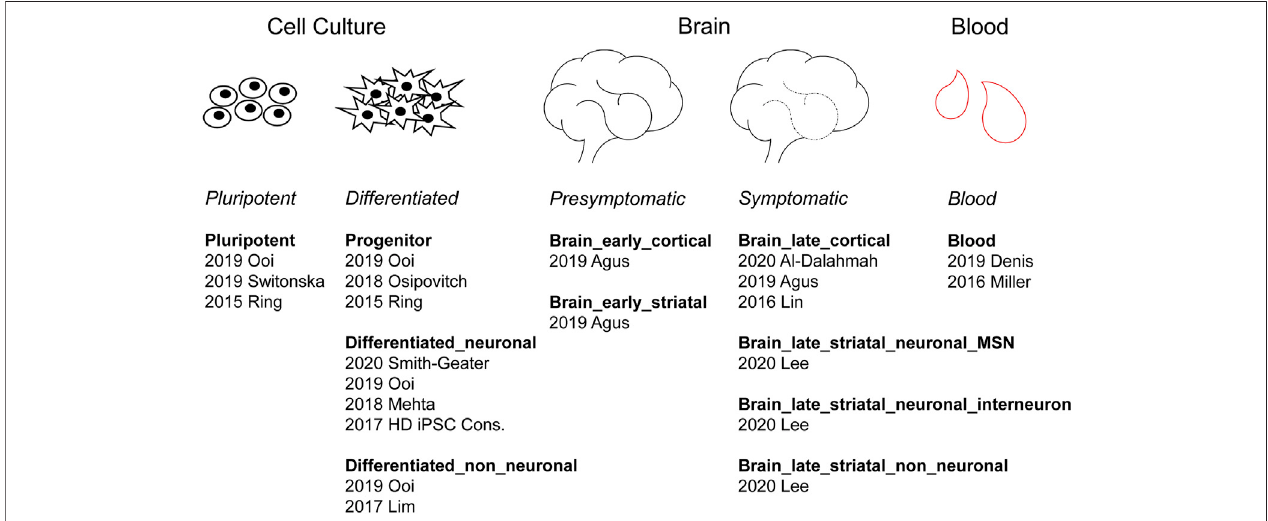
FIGURE 2 | Categorization of human HD differentially expressed gene (DEG) datasets. According to the sample source, human HD studies can be divided into three groups: cell culture, brain and blood. Cell culture studies can be further divided into pluripotent and differentiated subgroups. Brain studies can be divided into presymptomatic and symptomatic subgroups. Under each subheading are listed the respective studies identi fi ed by their publication year and the last name of the fi rst author.